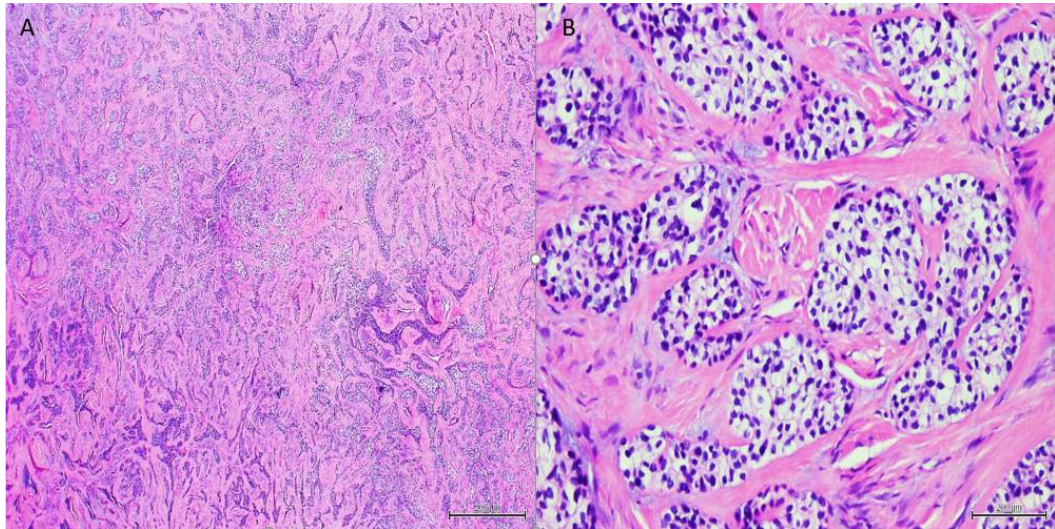
Figure 6. H&E, uncircumscribed neoplastic odontogenic epithelial proliferation, diffusely infiltrating the connect tissue stroma ( A , 40×). The neoplastic proliferation formed islands of variable size, trabeculae, and nests exhibiting central pleomorphic and hyperchromatic nuclei surrounded by clear cytoplasm ( B , 200×).